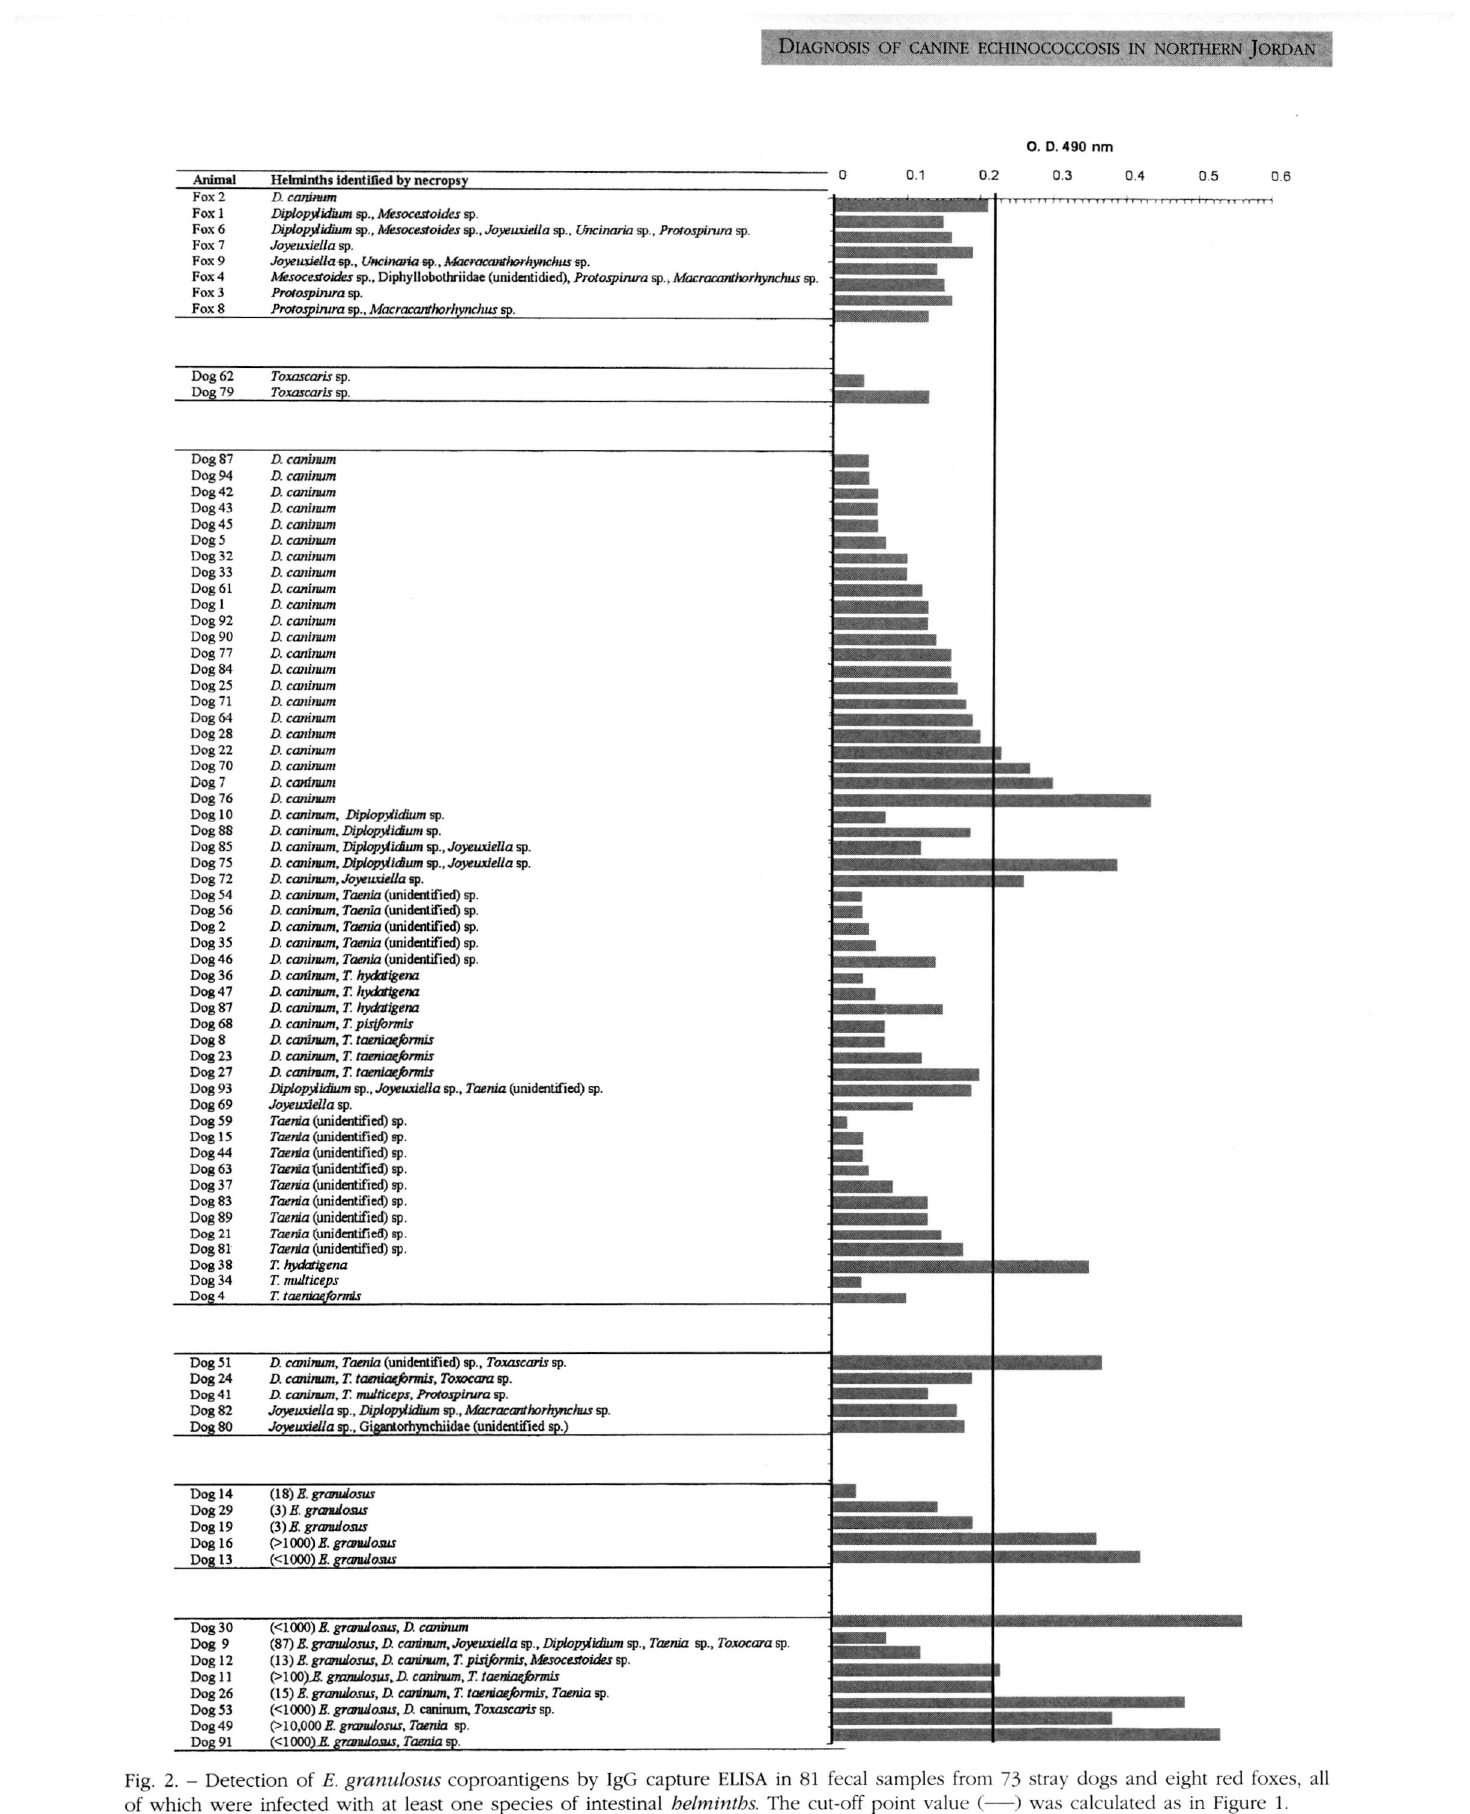
Fig. 2. - Detection of E. granulosus coproantigens by IgG capture ELISA in 81 fecal samples from 73 stray dogs and eight red foxes, all of which were infected with at least one species of intestinal helminths. The cut-off point value ( ) was calculated as in Figure